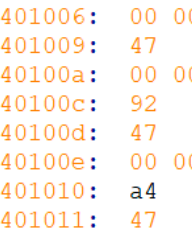
Figure 9. ASM file.